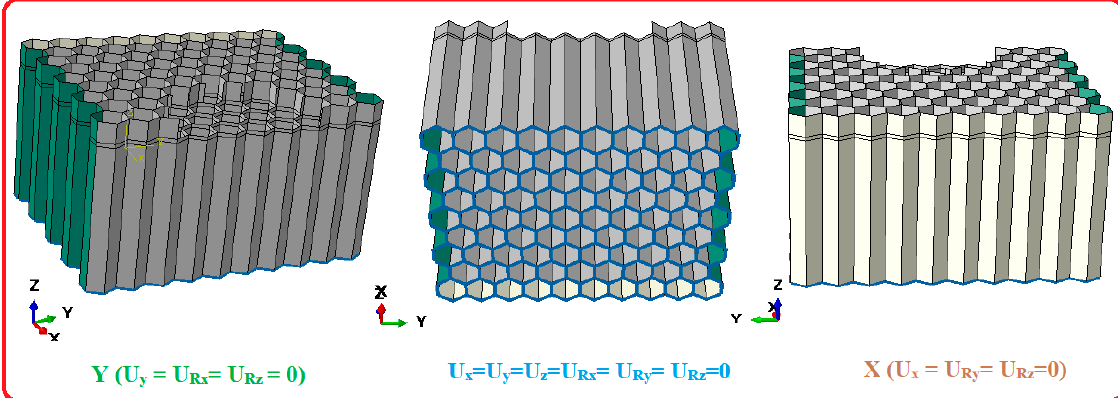
Figure 4. Boundary conditions used in the numerical simulation.